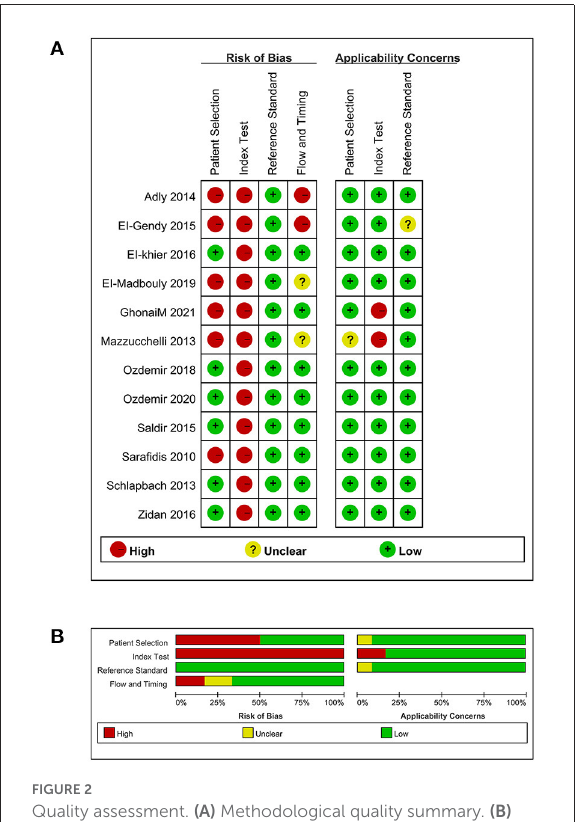
FIGURE2 Quality assessment. (A) Methodological quality summary. (B) Methodological quality